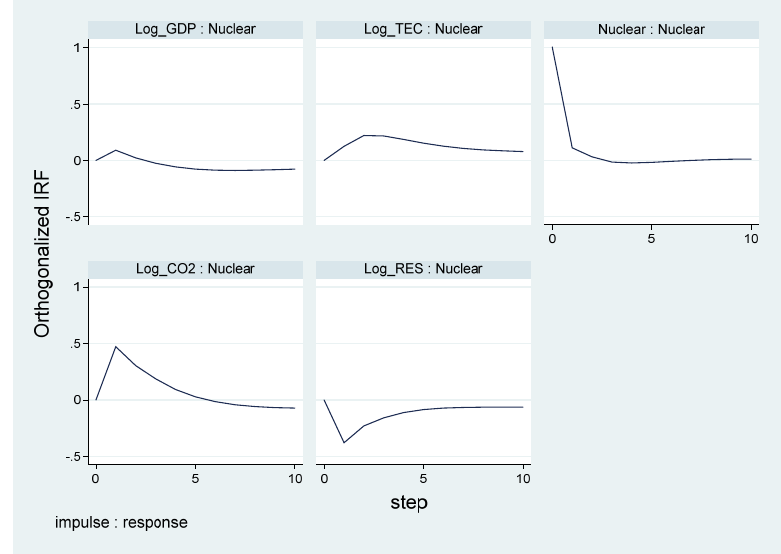
Energies 2022 , 15 , x FOR PEER REVIEW 15 of 23